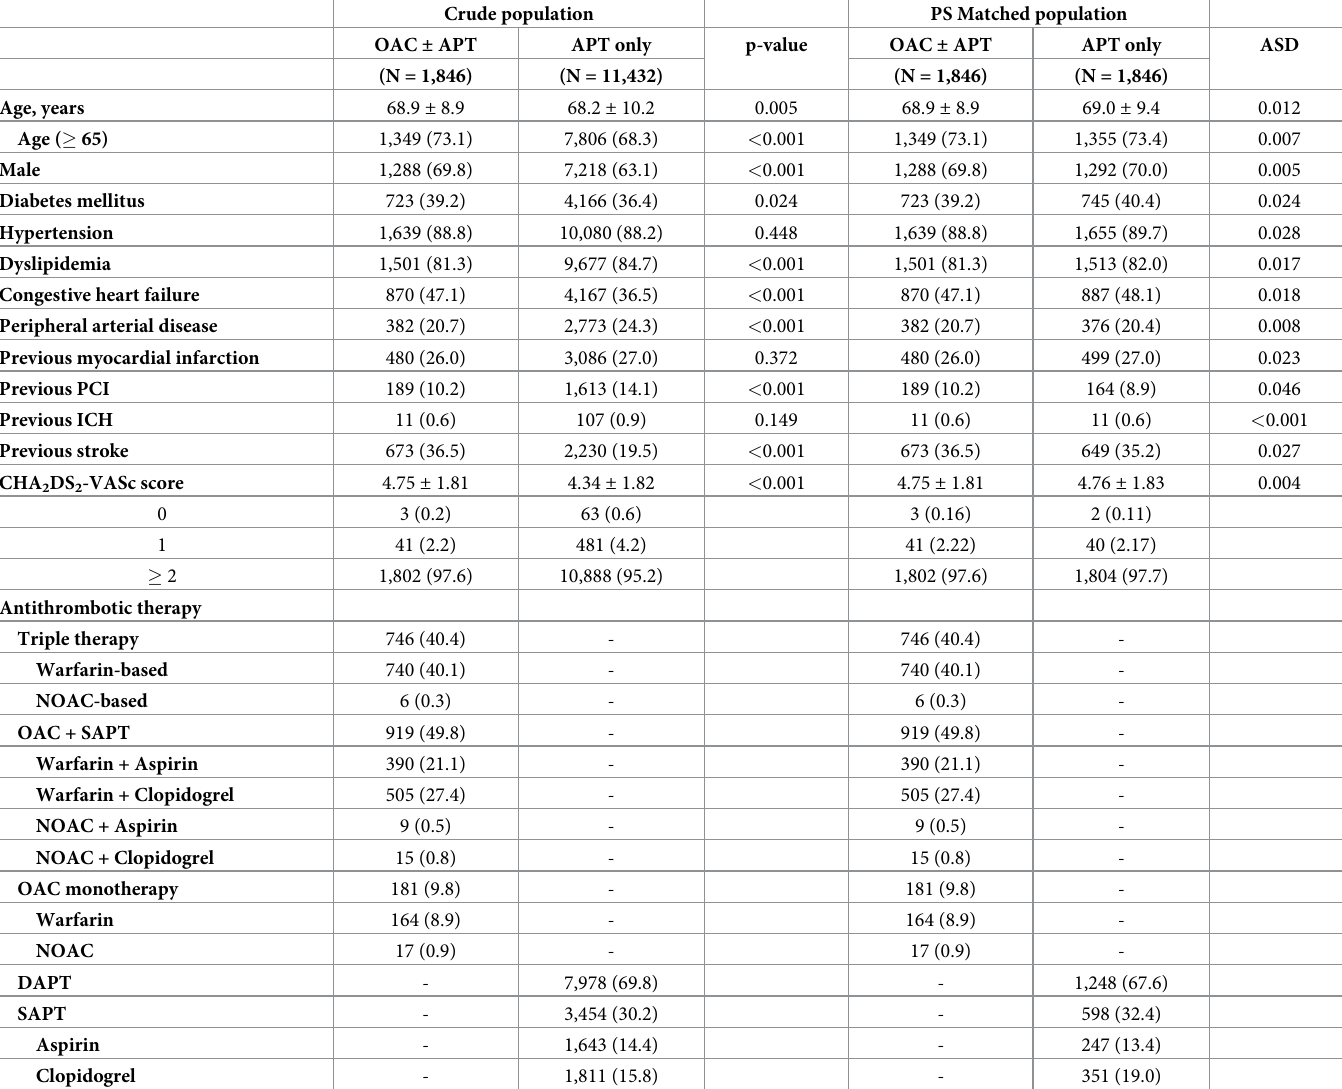
Table 1. Baseline characteristics of study population according to OAC prescription at 1-year after